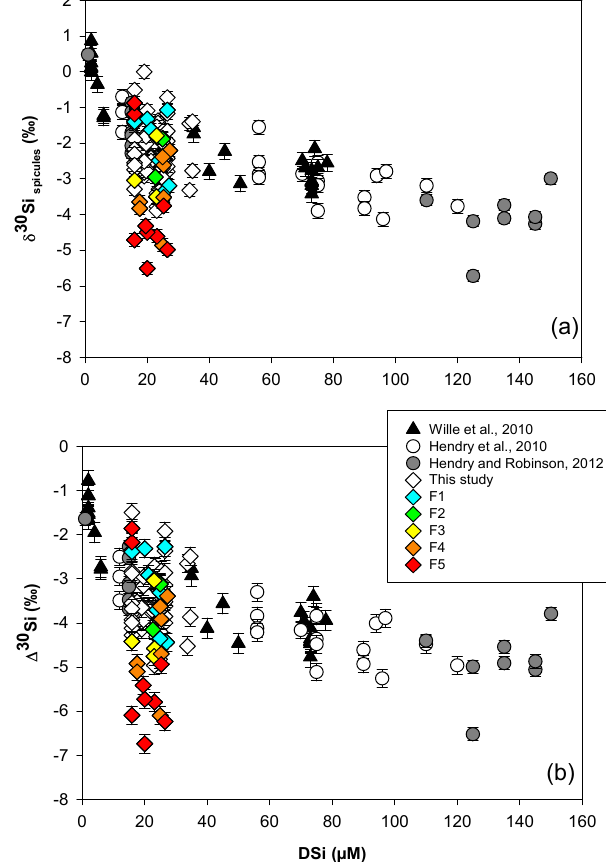
Figure 2. Sponge calibration data from Hendry et al. (2010) (Drake Passage and Scotia Sea), Wille et al. (2010) (Antarctica, Tasma- nia and New Zealand), Hendry and Robinson (2012) (North At- lantic, west Antarctic Peninsula, Woods Hole and North Pacific), and data from this study (equatorial Atlantic, JC094). (a) Sili- con isotopic composition of the spicules ( δ 30 Si Spicules ) and (b) deep sea sponges’ apparent Si isotopic fractionation ( δ 30 Si) against DSi concentration. Error bars for this study show 2SD, ± 0 . 13 for δ 30 Si Spicules and ± 0 . 17 for δ 30 Si. NB: core-top samples from Hendry and Robinson (2012) are not